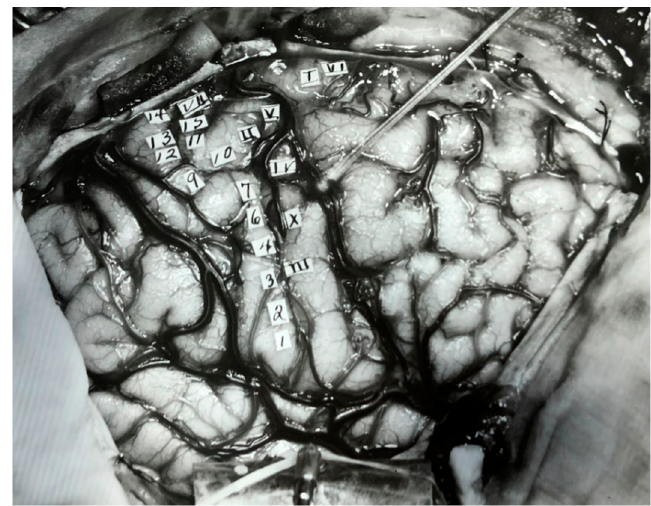
Figure 4. Regions in the right hemisphere indicated with Roman and Arabic numeral labels. The Roman numerals represent sites where electrical stimulation led to sensory perception, and the Arabic numerals indicate sites where stimulation lead to motor responses. Figure adapted with permission from Leblanc (2021).